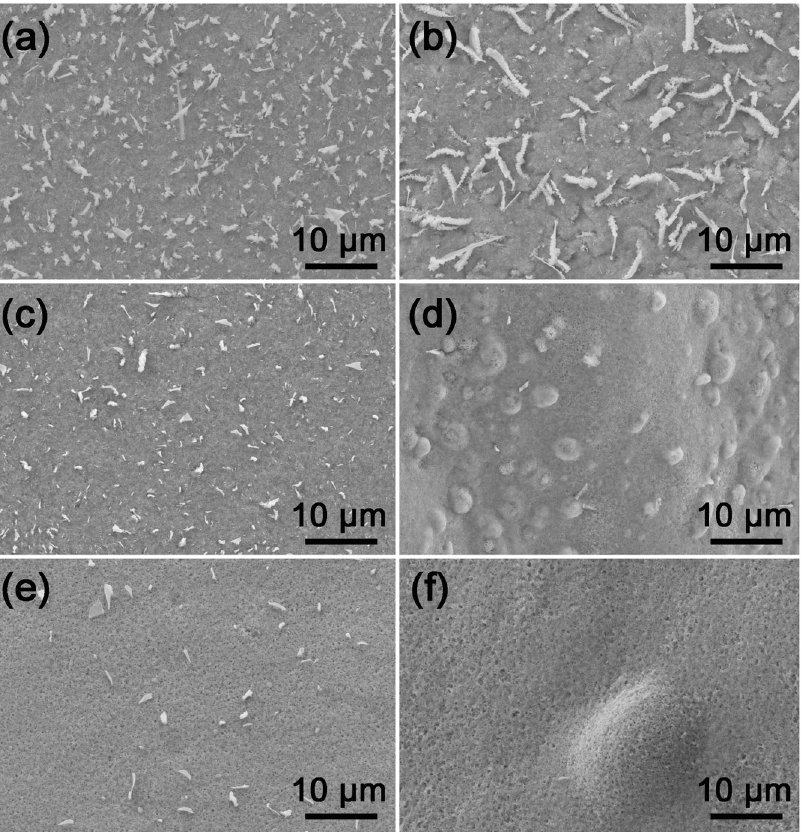
Fig. 3 SEM images showing the surface morphology of Cr-coated samples after oxidation at different conditions. a 1200 o C/0.5 h, b 1200 o C/1 h, c 1200 o C/2 h, d 1200 o C/4 h, e 1300 o C/0.5 h, f 1300 o C/1